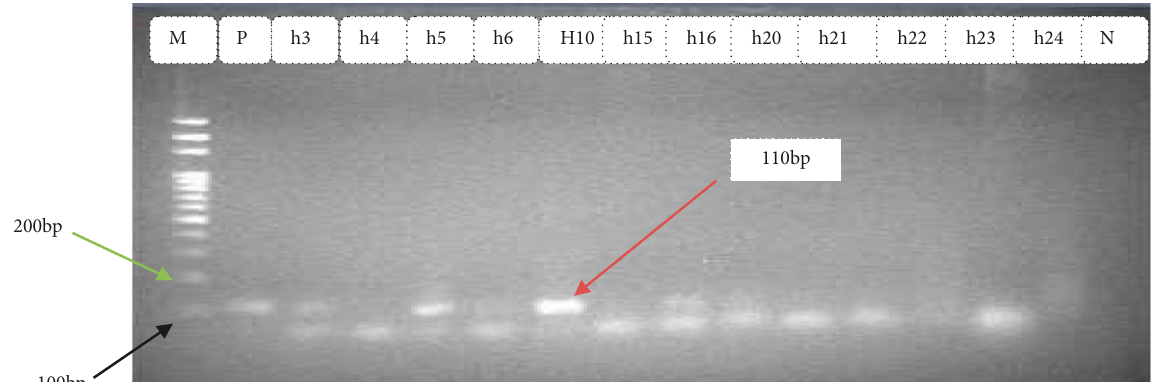
Figure 4: Amplification of stx2 gene in Escherichia coli isolates from diarrheic children: M Marker (100bp DNA ladder) P positive control, Lane No. h5, and h10 indicates positive samples, Lane No. h3, h4, h6, h15, h16, and h20–h25 indicates negative samples and N negative control.